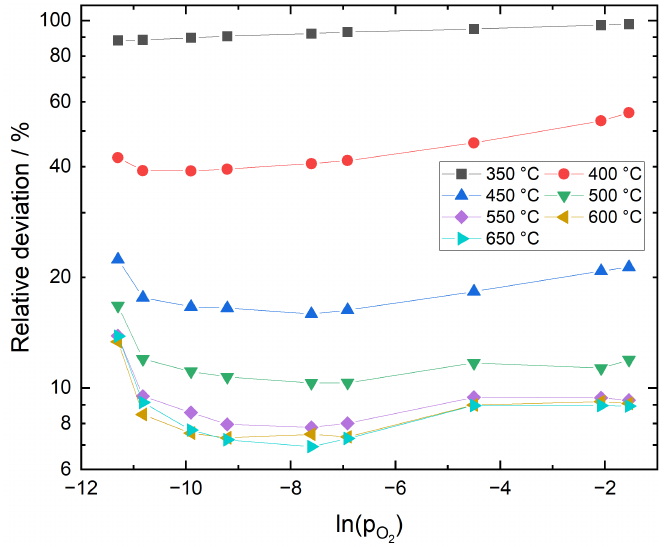
Figure 3. Relative deviation between theoretical reference oxygen partial pressures and values derived from